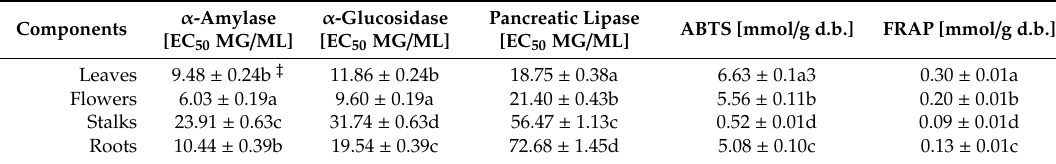
Table 3. The antioxidant activity and the biological activity in